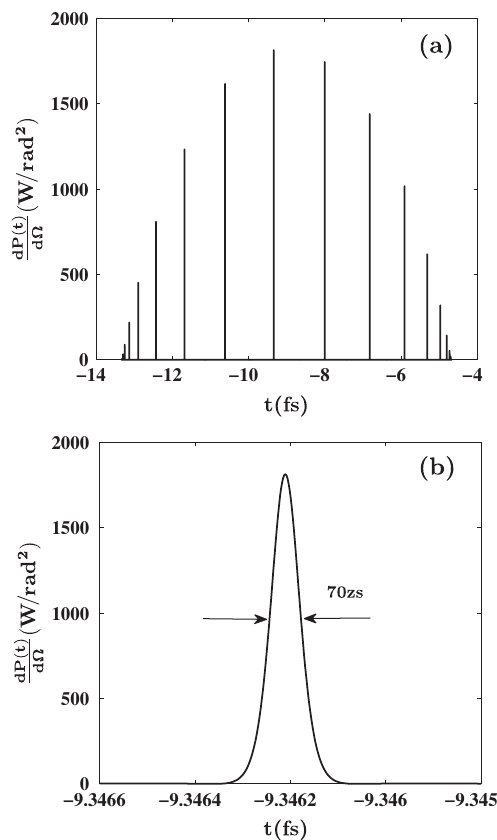
FIG. 4. (a) The time histogram of the radiation power per solid angle along the þ x axis by an electron scattering with a linearly polarized laser pulse. (b) The highest peak is magnified to show the details of the pulse shape. All of the calculation parameters are the same as those in Fig. 2 except that (cid:2) ¼ 1 and ^ n ¼ e x .